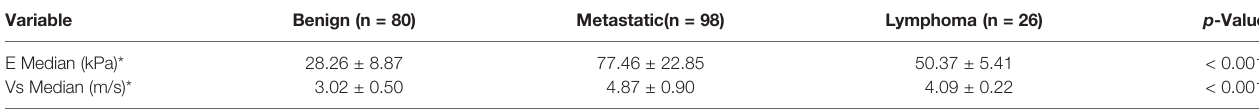
TABLE 2 | SWE parameters of LNs.